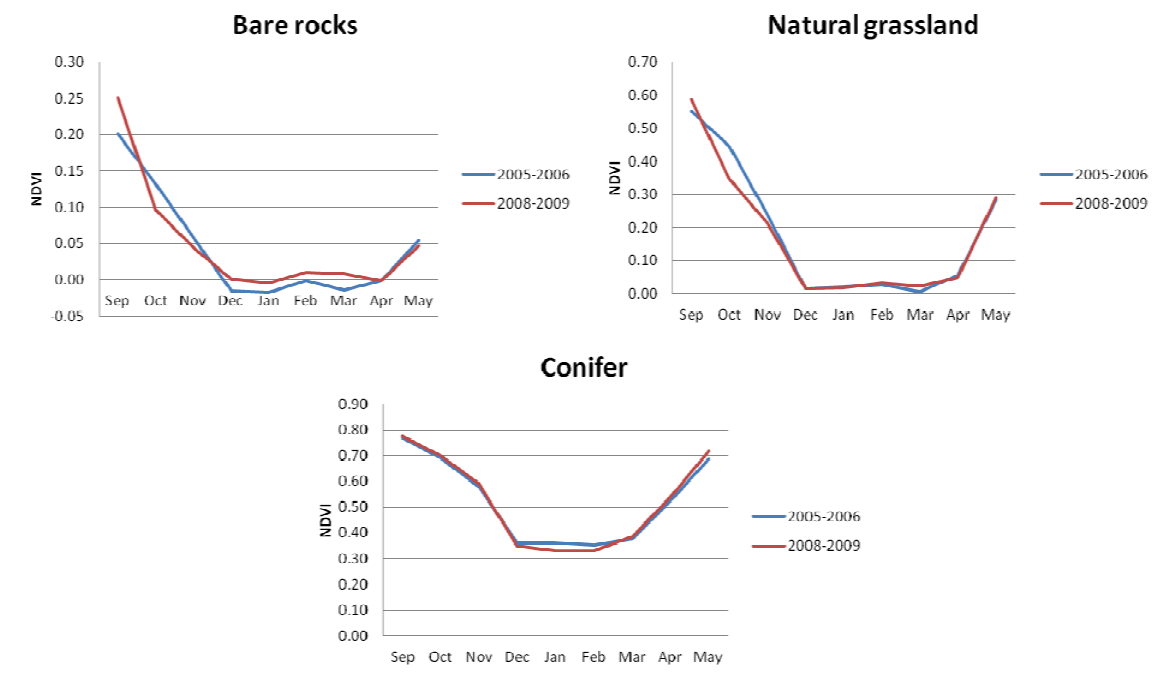
Figure 4. NDVI variability expressed in monthly averages from September to May in bare rocks, natural grassland and conifer